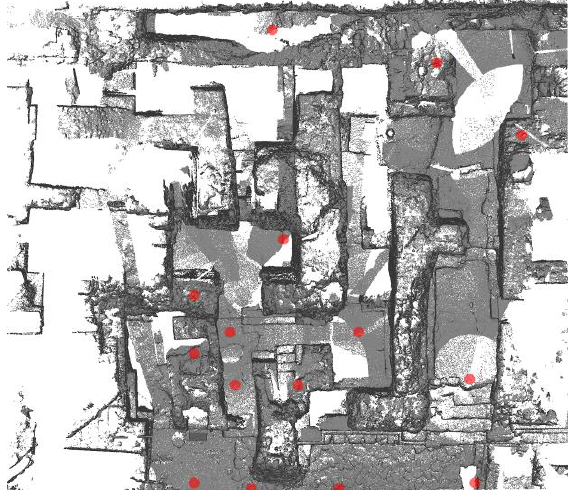
Figure 3. Scans location ( G. D’Agostino